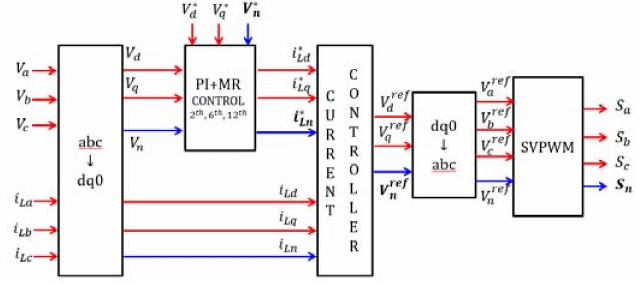
Figure 17. Block diagram of the PI + MR controller compensated nonlinear/unbalanced load.